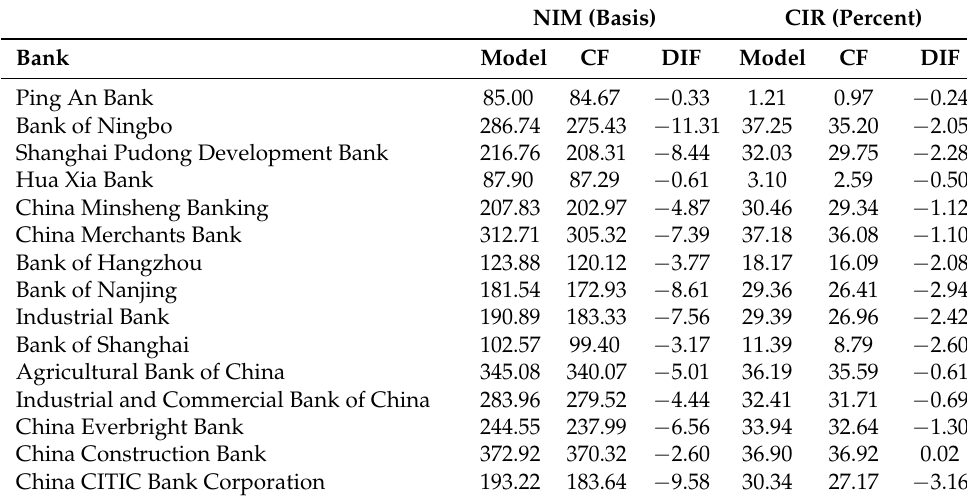
Table 6. Counterfactual Result: NIM and